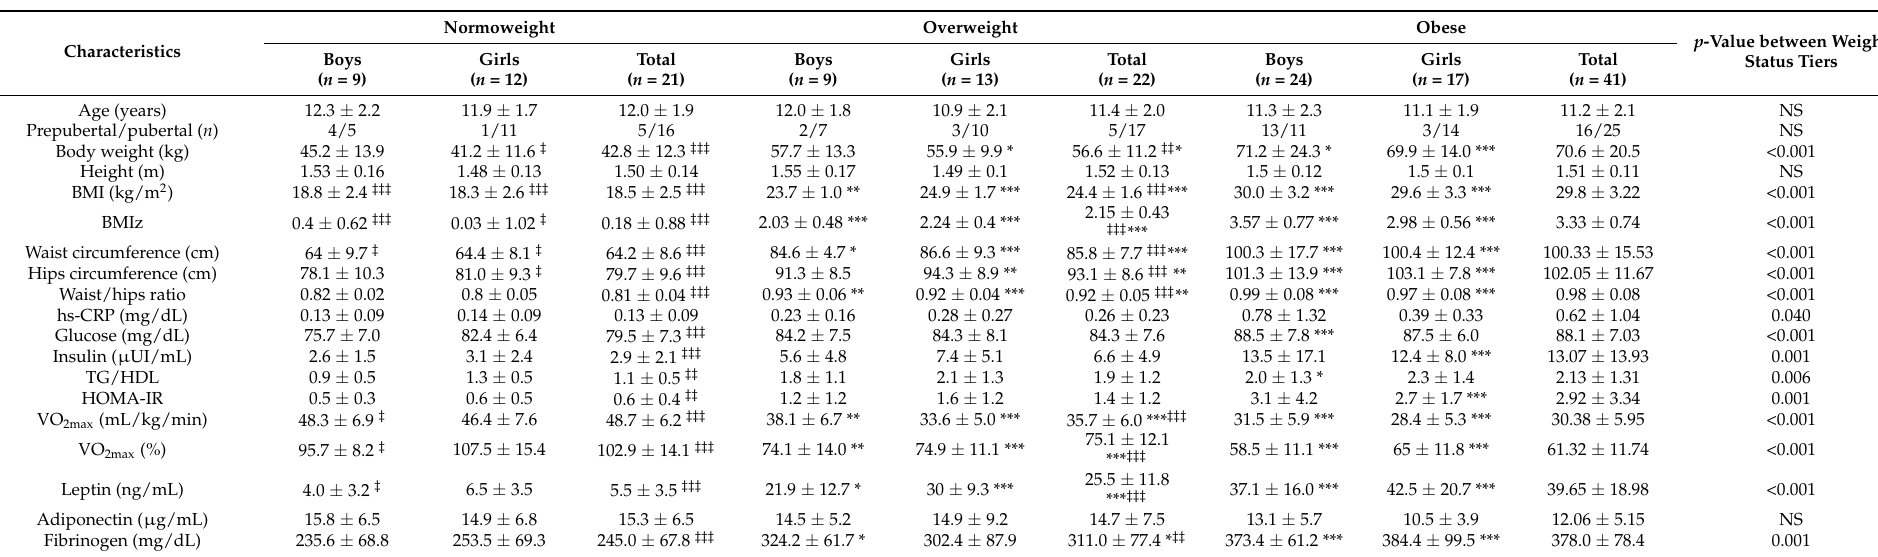
Table 2. Anthropometric, biochemical and exercise test parameters of participants according to sex and weight status (mean ±